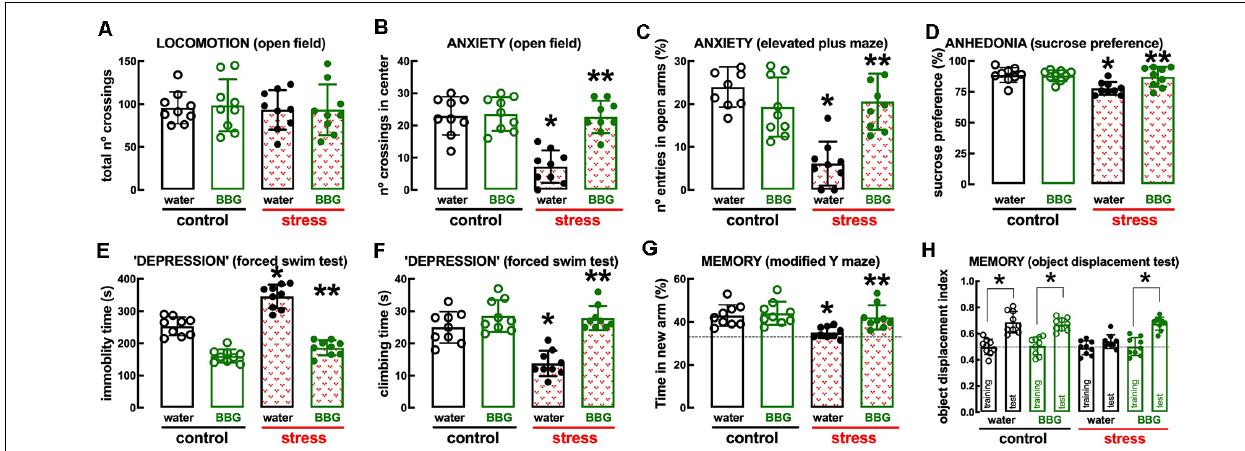
FIGURE 4 | Male adult Wistar rats (8–10 weeks old) subject to a protocol of restraint stress (4 h/day) during 14 days display the expected features of depressed rats, which were prevented by the P 2X7 receptor antagonist Brillant Blue G (BBG). Whereas BBG treatment (45 mg/kg, ip, daily, beginning 3 days before the stress protocol and until the sacrifice of the animals; green) was devoid of effects in non-stressed control rats (open bars), BBG prevented all behavioral modifications of stressed rats (red checkered bars): without modification of locomotor activity as evaluated in the open field (A) , BBG prevented anxiety-like behavior as evaluated in the open field (B) and in the elevated plus-maze (C) tests, anhedonia as evaluated in the sucrose preference test (D) , helpless-like behavior as evaluated by the forced-swimming test (E,F) and impaired memory performance as evaluated by a modified Y maze test (G) and an object-displacement test (H) . Data are shown as mean ± SEM; n = 8–9 rats per group. * P < 0.05 vs. control-water, ** P < 0.05 vs. stress-water using a Tukey’s multiple comparisons post hoc test after a two-way ANOVA.